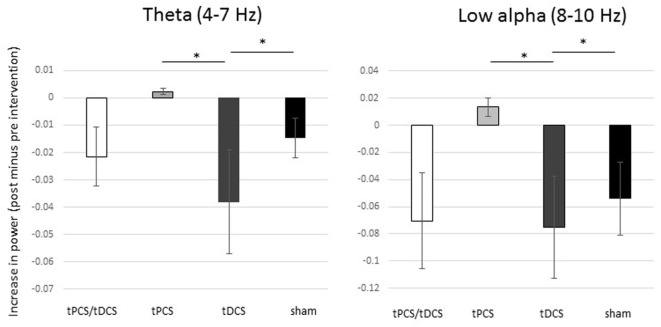
Differences in absolute power between groups. Mean differences (pre- versus post-intervention) of power for theta and low-alpha bandwidths. The bars represent the standard error. * Significant difference between groups.